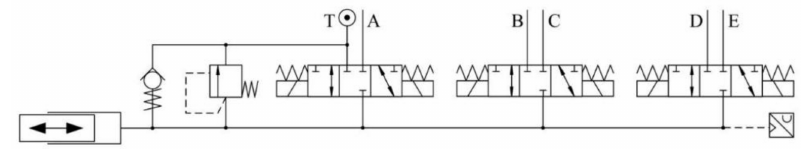
Figure 25. Schematic diagram of second generation